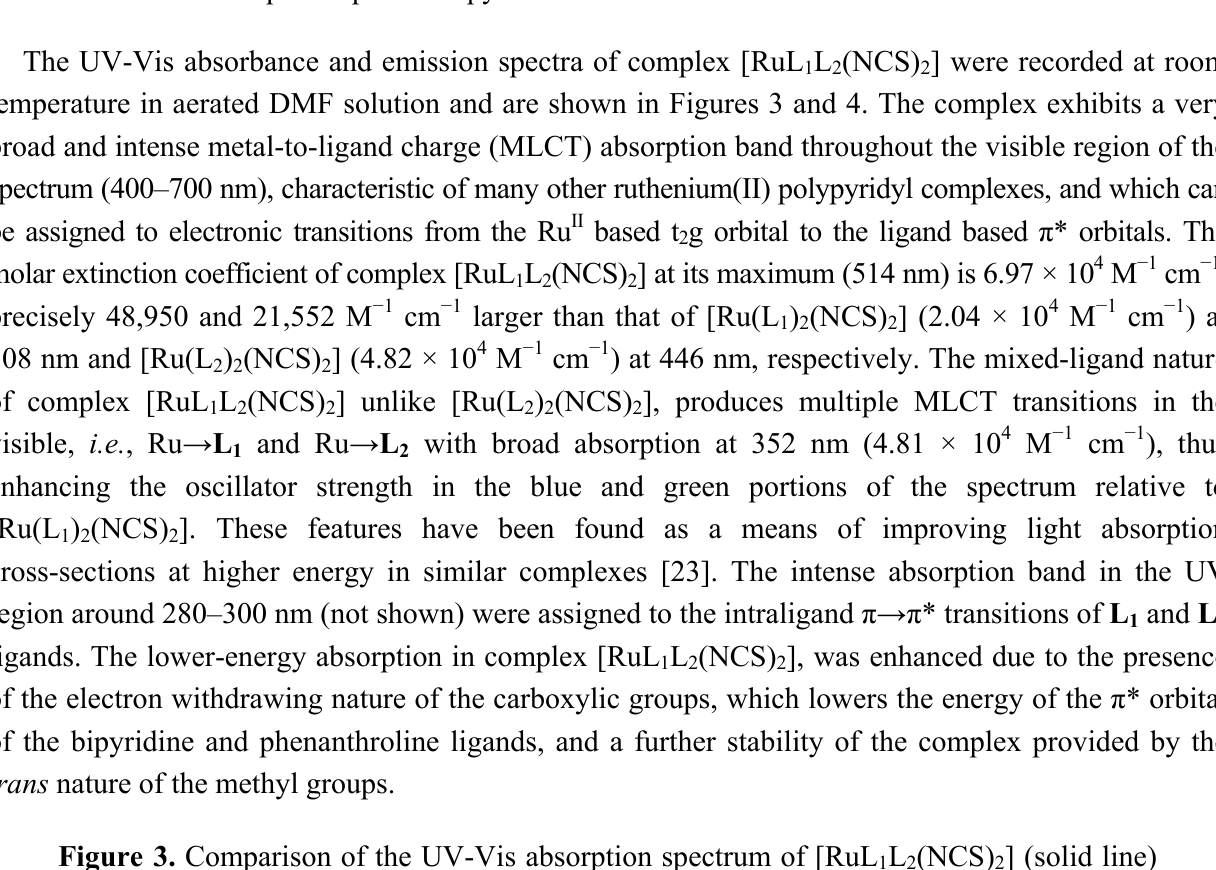
) (NCS) ] (dash line) and [Ru(L 1 2 2